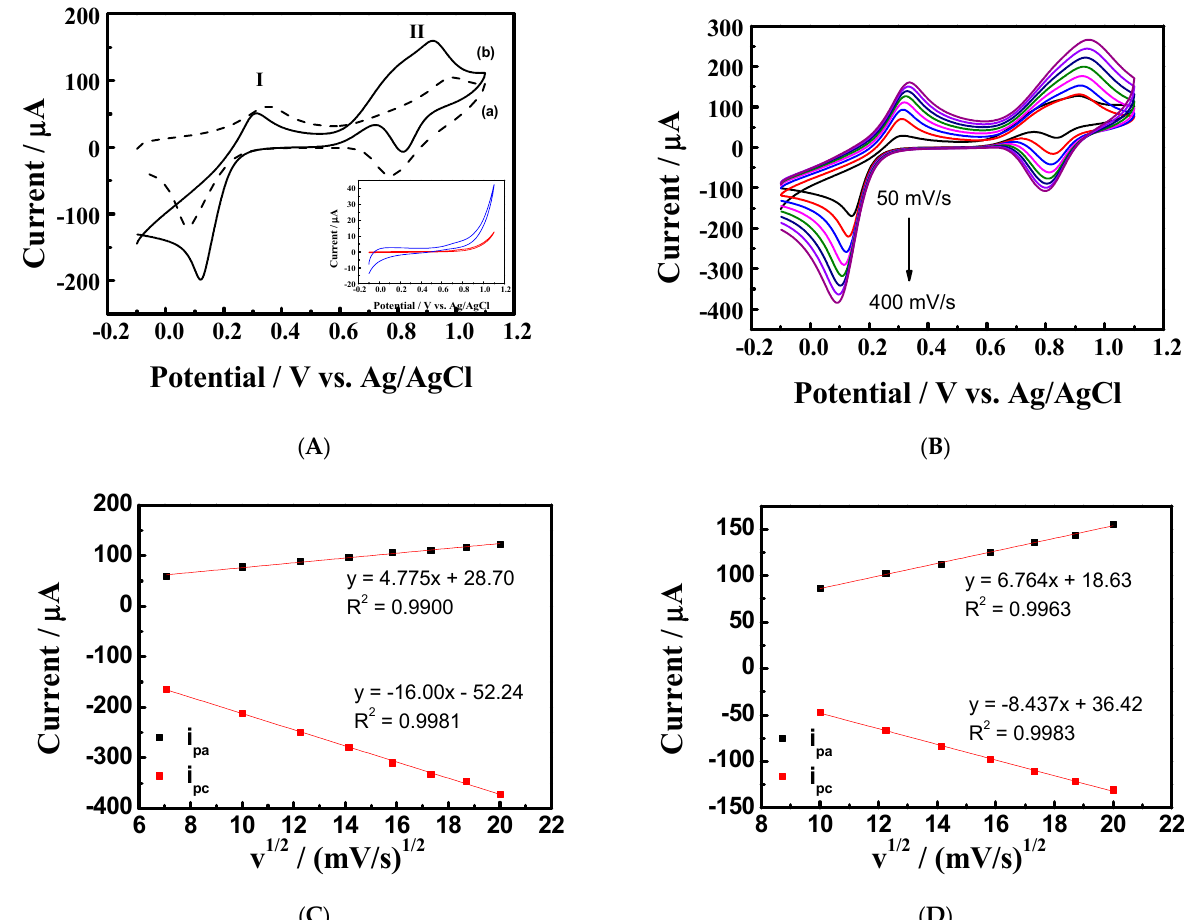
Figure 7. ( A ) Cyclic voltammograms of SPCE/nano − Fe 3 O 4 /PBNC (a) without, and (b) with 3.0 mM H 2 O 2 . Inset: Cyclic voltammograms of SPCE (red curve), and SPCE/nano − Fe 3 O 4 (blue curve) with 3.0 mM H 2 O 2 . The electrolyte solution is 0.1 M KCl, and 0.05 M PBS (pH = 7). ( B ) Cyclic voltammograms of SPCE/nano − Fe 3 O 4 /PBNC in 0.05M pH 7.0 PBS containing 0.1 M KCl and 3 mM H 2 O 2 at various scan rates of 50, 100, 150, 200, 250, 300, 350, and 400 mVs − 1 . Plots of anodic and cathodic peak currents versus the square root of scan rate for ( C ) redox peak I, and ( D ) redox peak II. Another application is to develop an electrochemical assay for the indirect determi- nation of glyphosate. With the impact of glyphosate on the formation of stable PBNC on nano-Fe 3 O 4 , it is expected that the amounts of PBNC formation must be a function of the glyphosate concentration. As shown in Figure 8A, visible redox peaks originating from PB/PW were observed in the glyphosate concentrations ranging from 50 μ M to 1000 μ M. Nonetheless, it is challenging to find this redox peak in a more diluted solution at an am- bient temperature. In a mixture solution containing 10 μ M glyphosate, the pH value reaches 5.3. This weak acidity limits the initial iron release from magnetite nanoparticles, thereby hindering the formation of PB. The cathodic peak currents of the PB/PW were analyzed further. At an ambient temperature, a linear relationship with glyphosate con- centration from 50 μ M to 1000 μ M was given by the equations: Y ( μ A) = 0.1454 X ( μ M) + 3.7186 (R 2 = 0.9996) (Figure 8C, Curve a). An increased temperature in the electrolytic so- lution is supposed to affect the dissolution of nano-Fe 3 O 4 , increasing the PB formation.